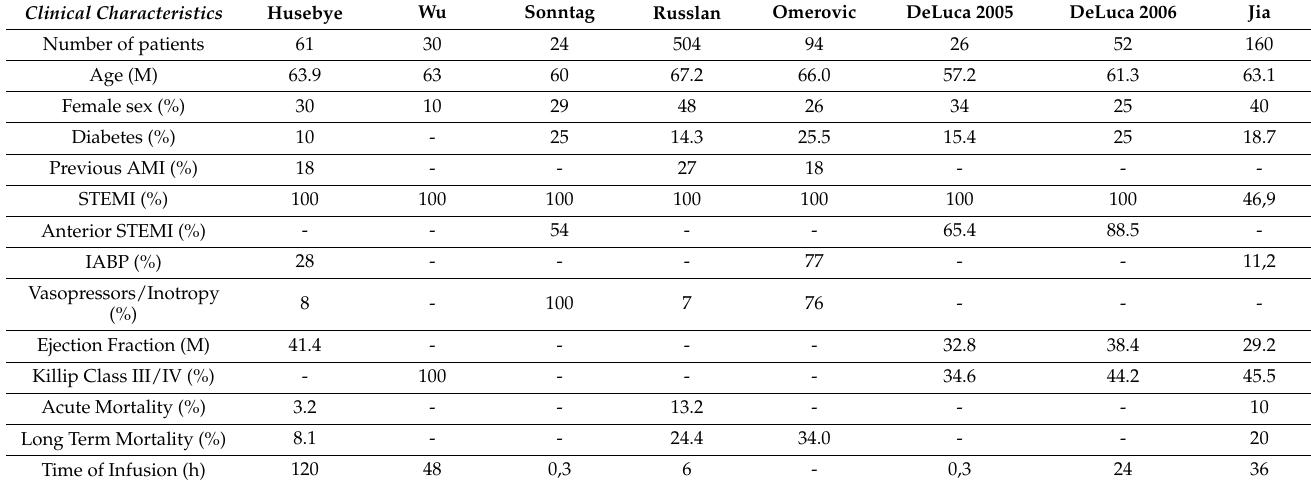
Table 3. Population clinical characteristics of studies involved in meta-analysis.